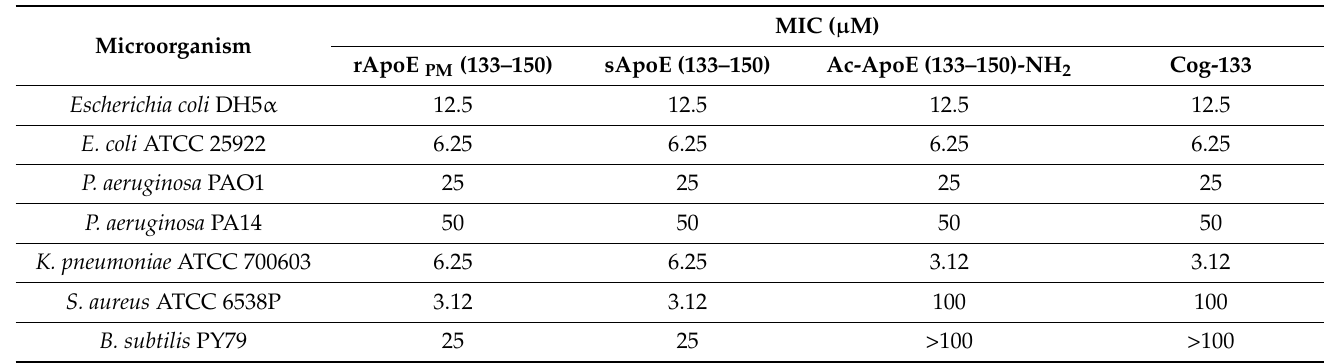
Table 2. Antibacterial activity of ApoE-derived peptides. Adapted from ref. [7].